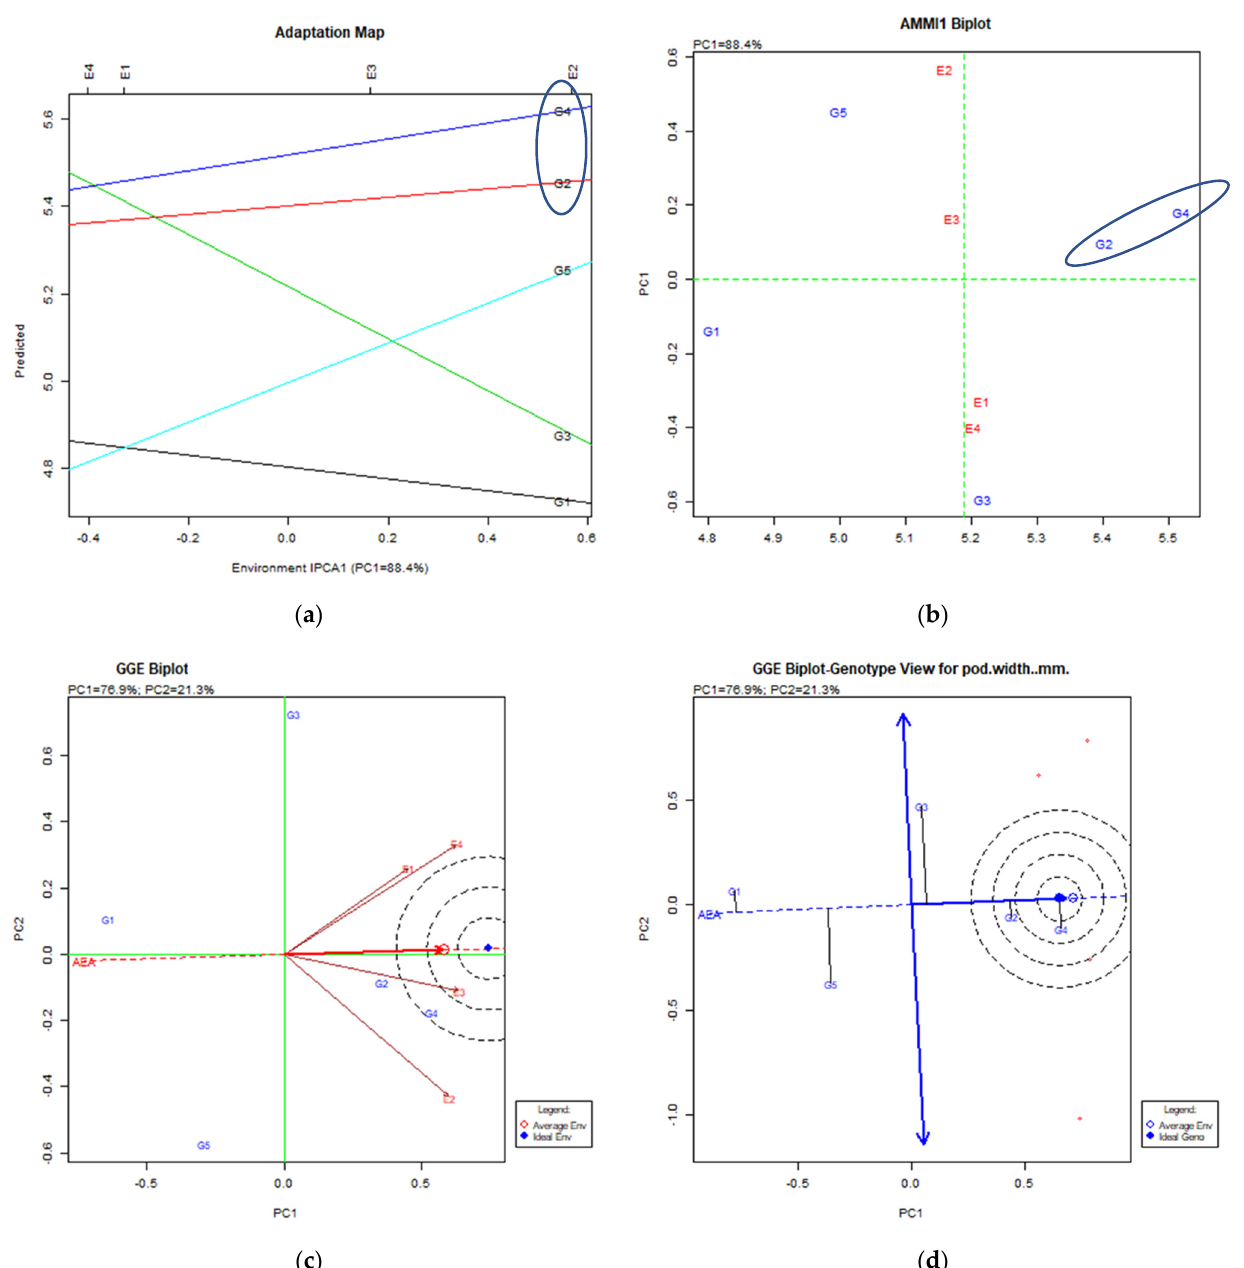
Figure 9. Stability analysis for pod width (mm) based on: ( a ) the adaptation map where the X-axis (PC1) visualizes the stability of cultivars over environments and the Y-axis—the performance of cultivars for the trait; ( b ) the AMMI1 biplot where the Y-axis is the one visualizing the trait performance and the X-axis (PC1) visualizes the stability of cultivars over environments; ( c ) the GGE biplot for environments depicting the stability of the environments over years via the placement as near as possible to the ideal and average environment; ( d ) the GGE biplot for cultivars depicting the stability of the cultivars over environments where the productive cultivars are those to the right on the AEA vector and the stable ones are those which are as close to the AEA axis as possible.